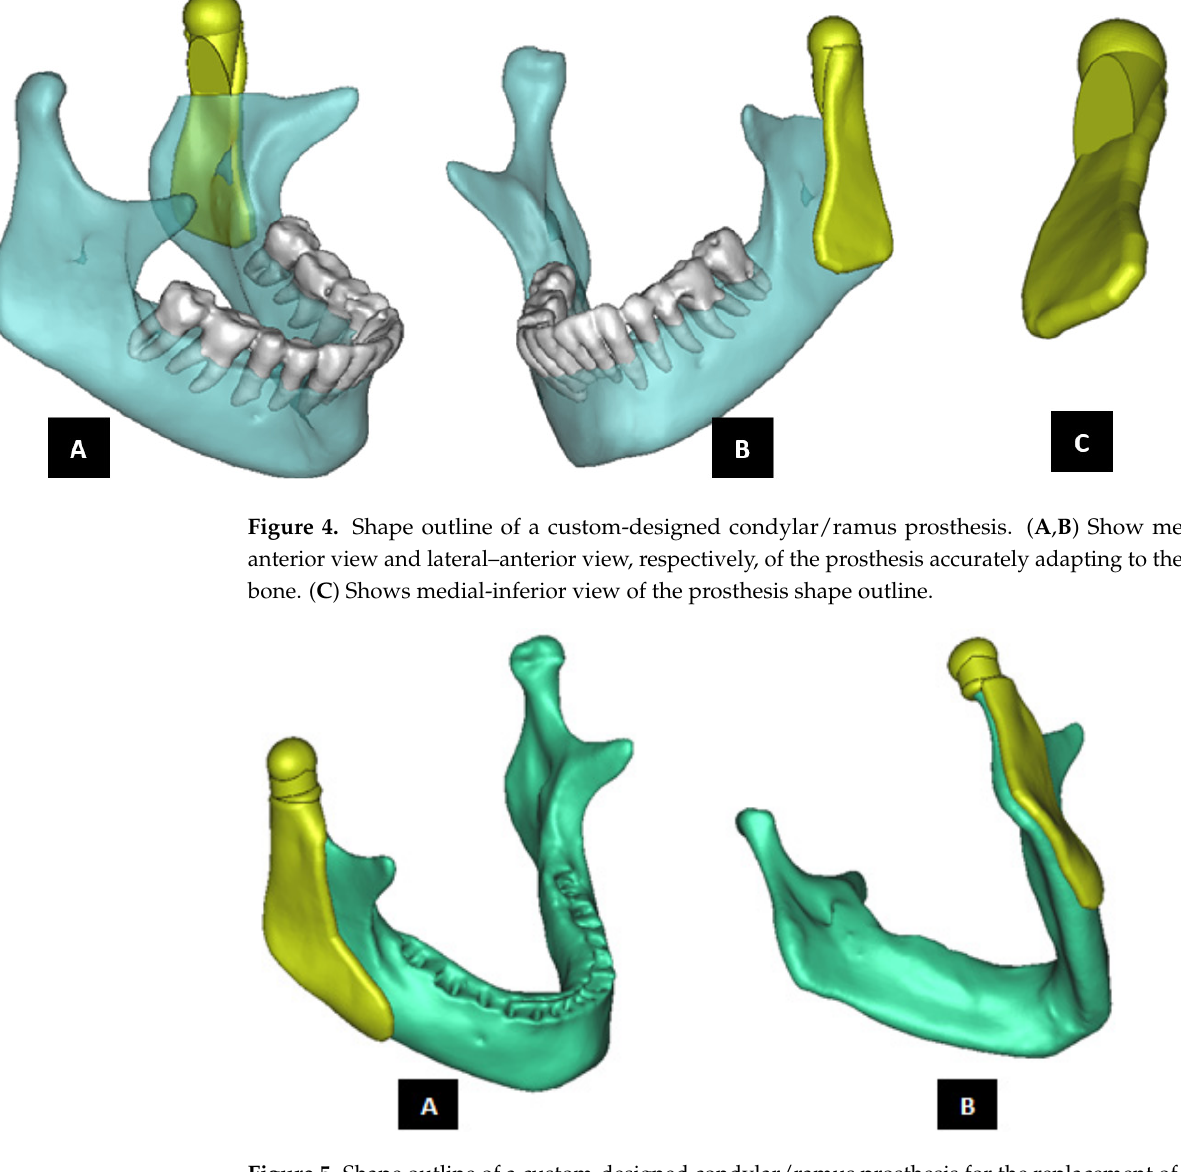
Figure 5. Shape outline of a custom-designed condylar/ramus prosthesis for the replacement of right TMJ of a patient. ( A , B ) Show lateral–anterior view and lateral–posterior view, respectively, of the prosthesis accurately conforming to geometric shape of patient’s